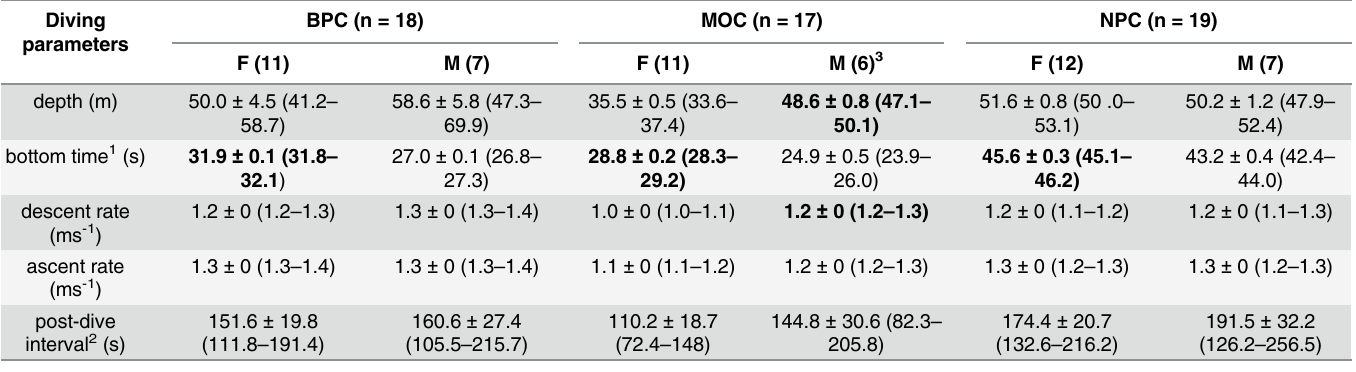
Table 4. Dive characteristics (using the mean value per bout) of female and male murres during three stages of the annual cycle. Values are GLMM model fits (mean ± SE) and 95% CI (in brackets) by sex according to stage. Bold indicates significant within stage sex differences, with the highest value in